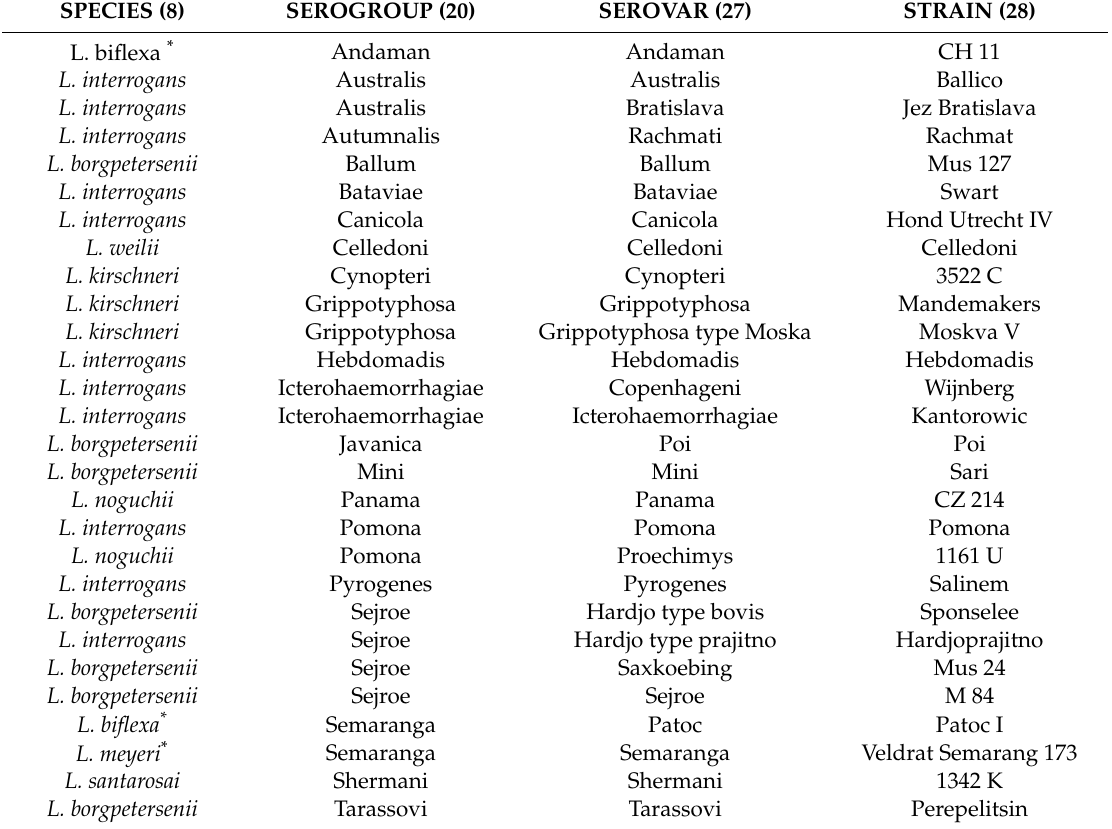
Table 1. Species, serogroup, serovar, and strain from Leptospira tested among 244 cats from Spain. SPECIES (8) SEROGROUP